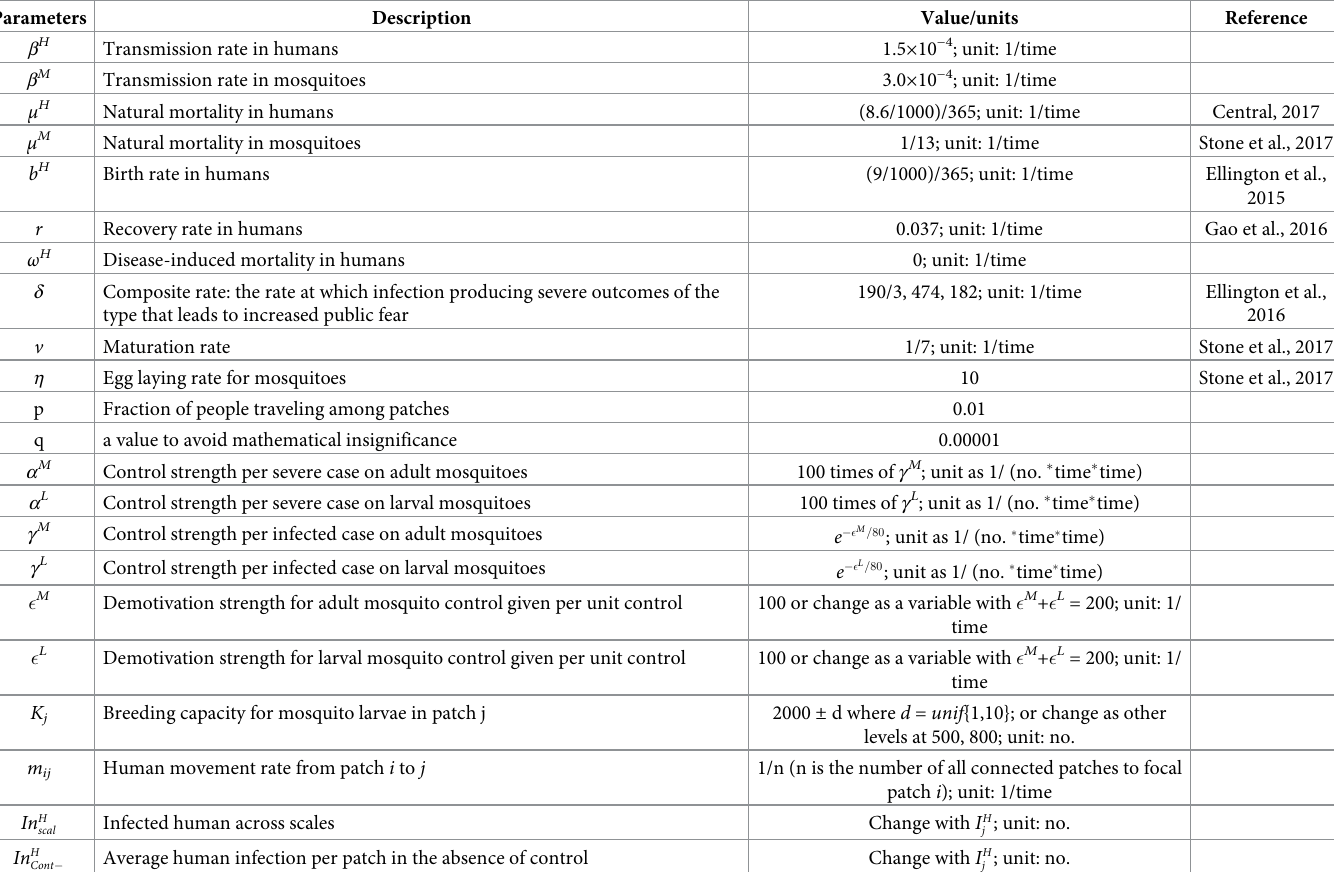
Through this SIR model under human meta-population structure, we first analytically studied the general relationship between total control effort ( C M þ C L ) and disease information across t t scales, including the potential effects from early intervention and strength reinforcement. Specifi- cally, we simulated the dynamics of total control effort as well as the average human infections per patch under three information scales: local, regional, and global, and further calculated the corre- sponding control efficacy (i.e., the reduction of infection achieved per unit of control; In H Cont (cid:0) (cid:0) In H scal ). C M t þ C L t Table 2. All parameters and their corresponding values in the model. Some parameter values were chosen from the incidence and mortality in early Zika outbreaks in South America (see Reference).